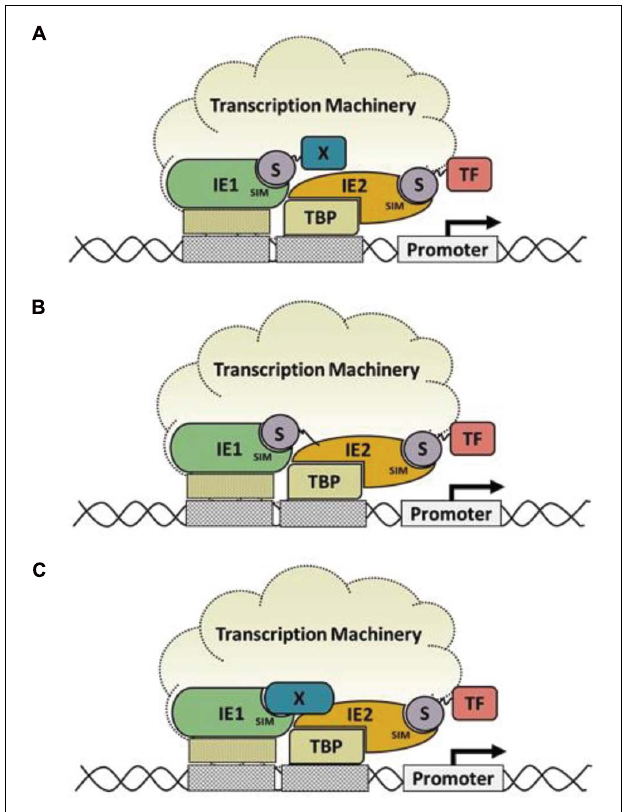
FIGURE 5 | Models of IE1 enhanced IE2 transactivation activity: (A) A model of IE1-SIM1 enhanced transactivation activity, where IE1-SIM1 interacts with a SUMOylated transcription factor (X) to enhance IE2 transactivation. (B) An alternate model is where IE1-SIM1 interacts with IE2 ∼ SUMO by non-covalent SIM/SUMO interaction. (C) Another possibility is that factor X interacts with IE1 on the surface, corresponding to IE1-SIM1 in SUMO independent